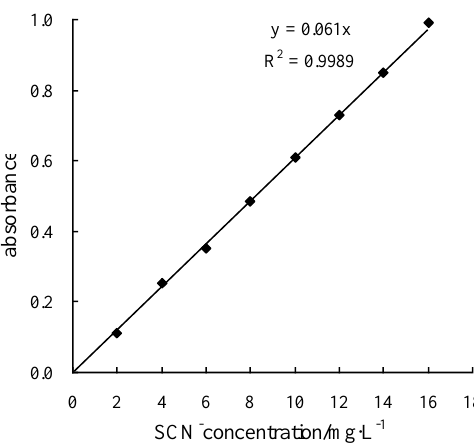
Figure 5. The tracer concentration–absorbance standard curve.